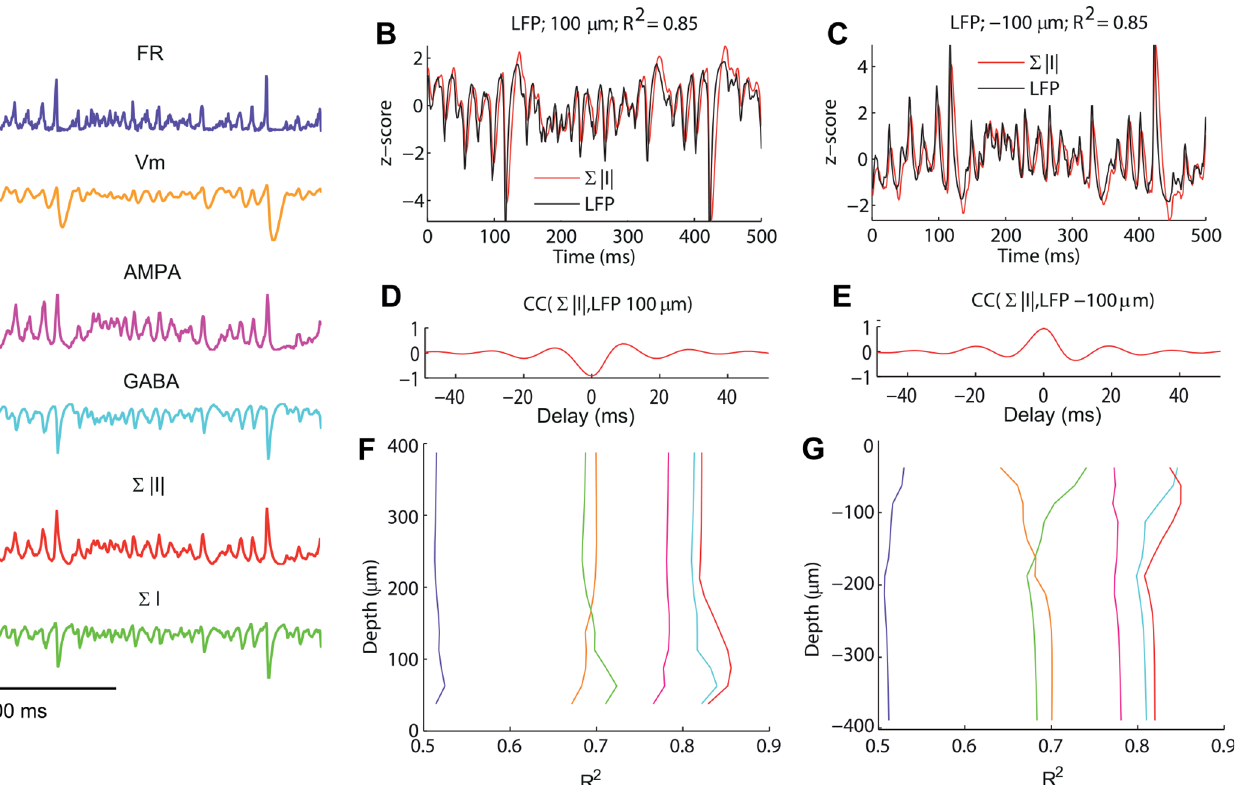
Fig 4. Performance of candidate LFP proxies. (A) Illustrations of predictions of LFP time courses from candidate LFP proxies. From top to bottom: firing rate (FR), membrane potential (V m ), AMPA currents, GABA currents (note: these have a negative sign), sum of absolute values of AMPA and GABA currents ∑ | I |, sum of AMPA and GABA currents ∑ I . Results are shown for a thalamic stimulation of 1.5 spikes/ms, and the proxies are normalized to have variance equal to one (see text),. (B-C) time course of the LFP signal (black) for reference depths 100 μ m (B) and -100 μ m (C) compared to the best matching proxy, ∑ | I | (magenta). The title indicates the fraction of variance explained (85% in both cases). (D-E) Cross-correlation in time between the LFP and the ∑ | I | proxy for the two depths. Note that the peaks corresponding to the highest cross-correlation magnitudes corresponded to a lag of 1 ms, i.e., the LFP was best predicted by the value of ∑ | I | one millisecond in the past. (F-G) Fraction of LFP signal variance explained by different LFP proxies with optimal delay (same color code as (A)). as a function of depth. The sum of absolute values of the synaptic currents ∑ | I | was the best proxy, followed by the use of GABA alone. The firing rate FR was a poor proxy, and the other three were moderately good